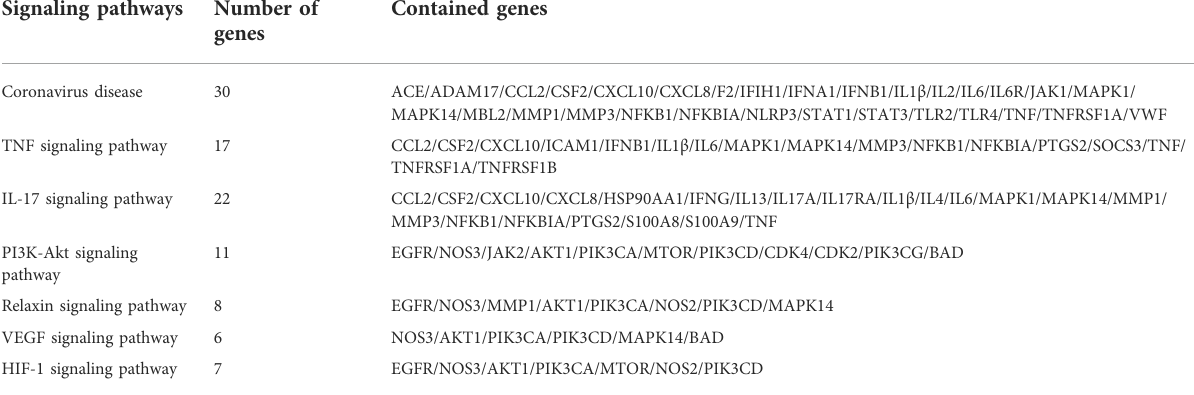
TABLE 1 The analysis results of important signaling